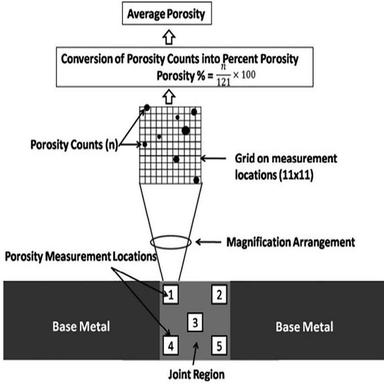
Schematic representation of porosity measurement in joint region .